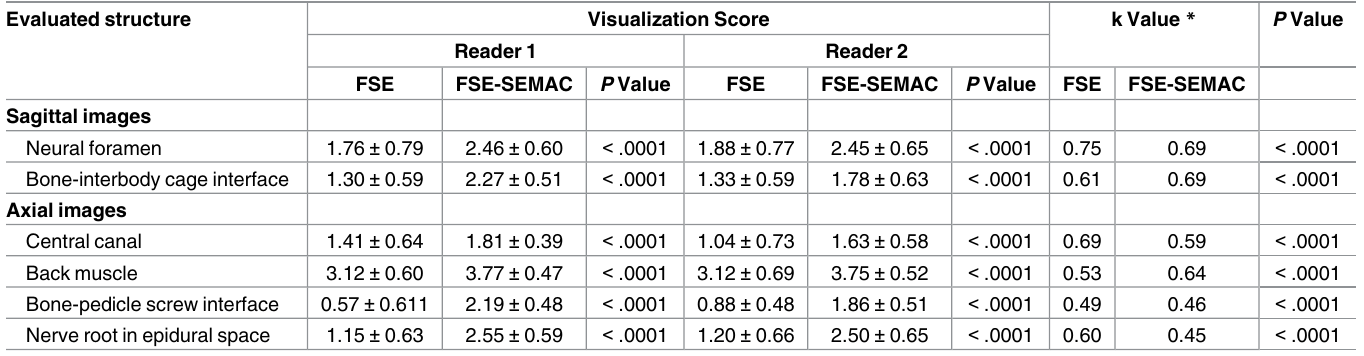
Table 2. Image quality scores for comparison of FSE sequence versus FSE-SEMAC sequence. Evaluated